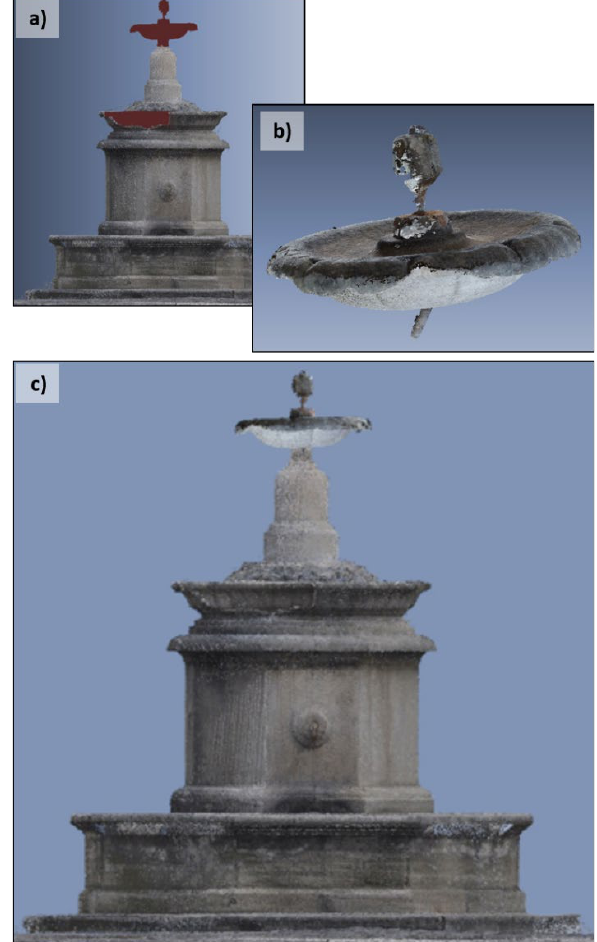
Figure 13. The 3D model of the fountain (about 250000 triangles) before (a) and after (c) the virtual restoration. In b) the damaged missing part reconstructed by